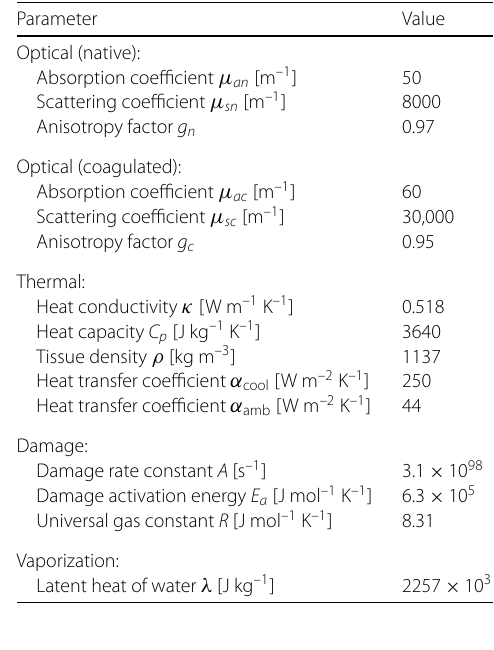
Figure 3 Comparison of the models for the case